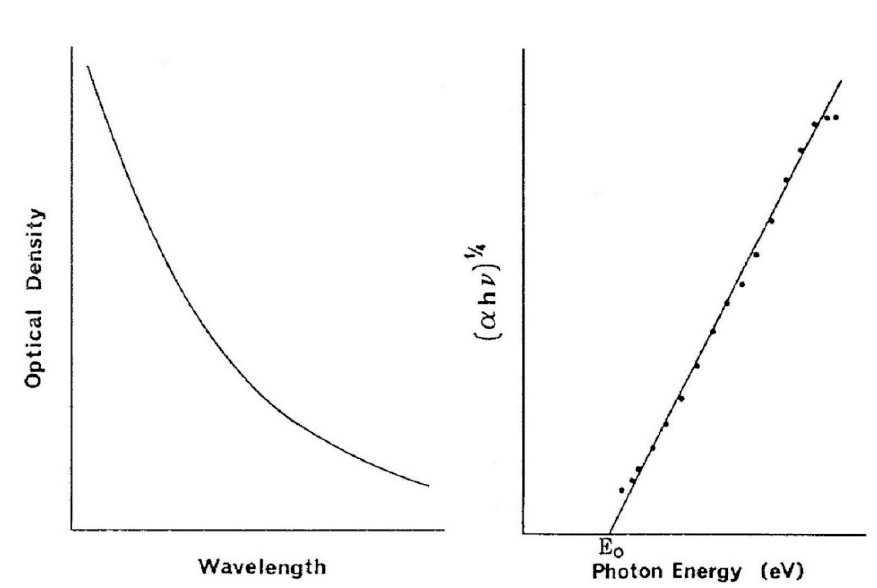
Figure 19. Absorption spectrum of melanin and its mathematical translation.